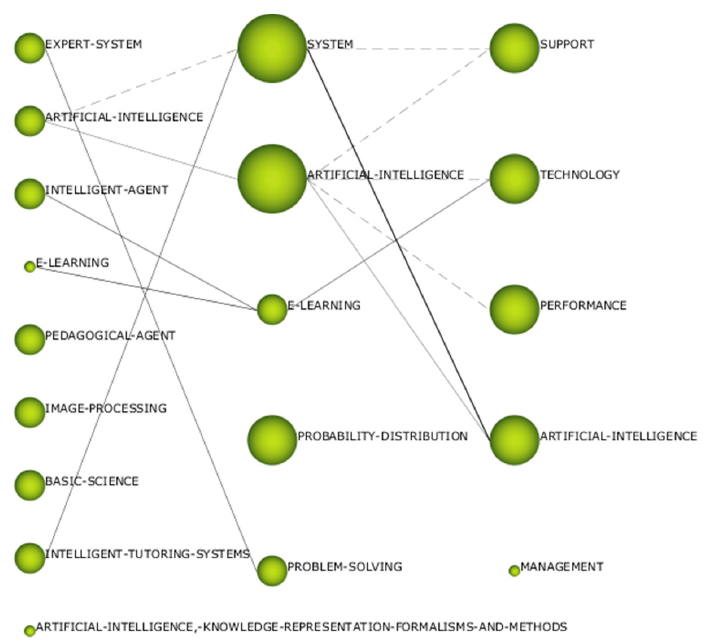
Figure 5. Thematic evolution by h-index.